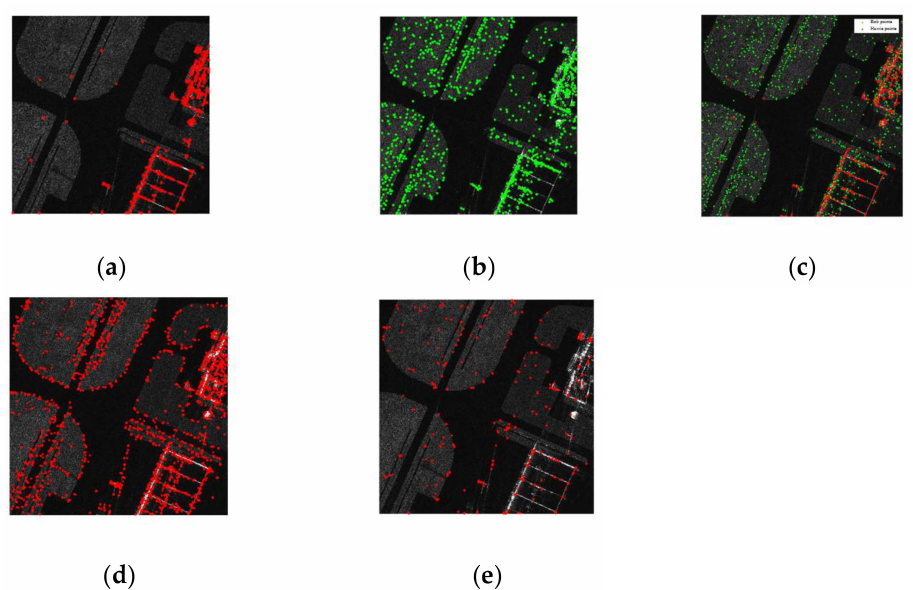
Figure 2. Schematic diagram of interest points corresponding to five detectors: ( a ) Har-Lap. ( b ) DoG. ( c ) Har-DoG. ( d ) SAR-Harris. ( e )